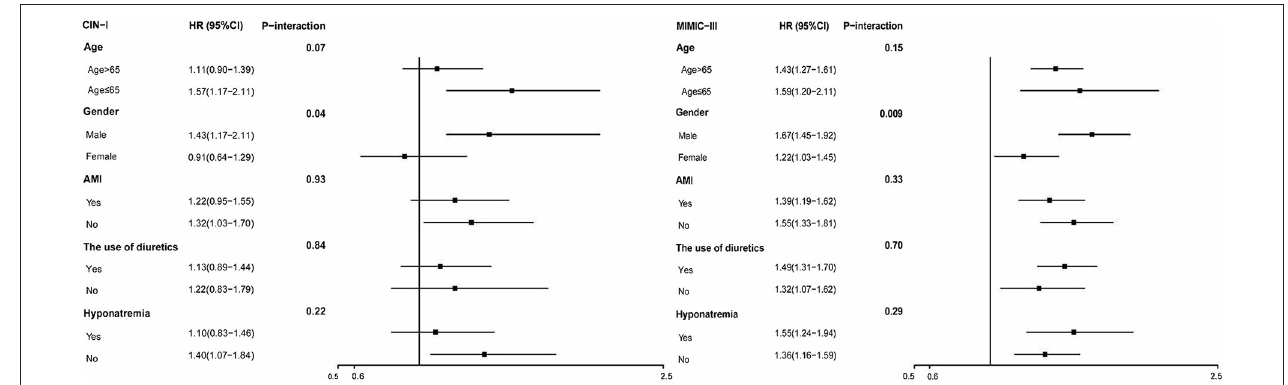
FIGURE 4 | Hazard ratios for long-term ACM in different subgroups (hypochloremia vs. non-hypochloremia).